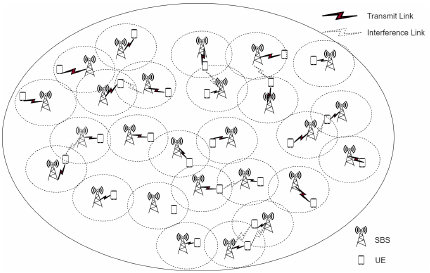
Figure 1. Ultra-dense small cell network